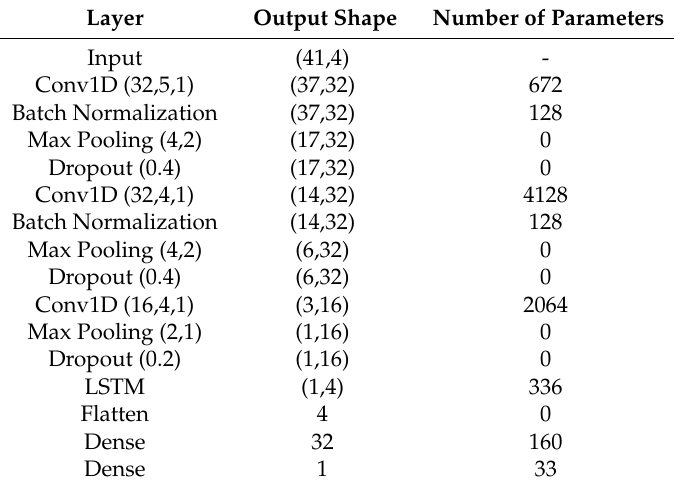
Table 1. Architecture details of